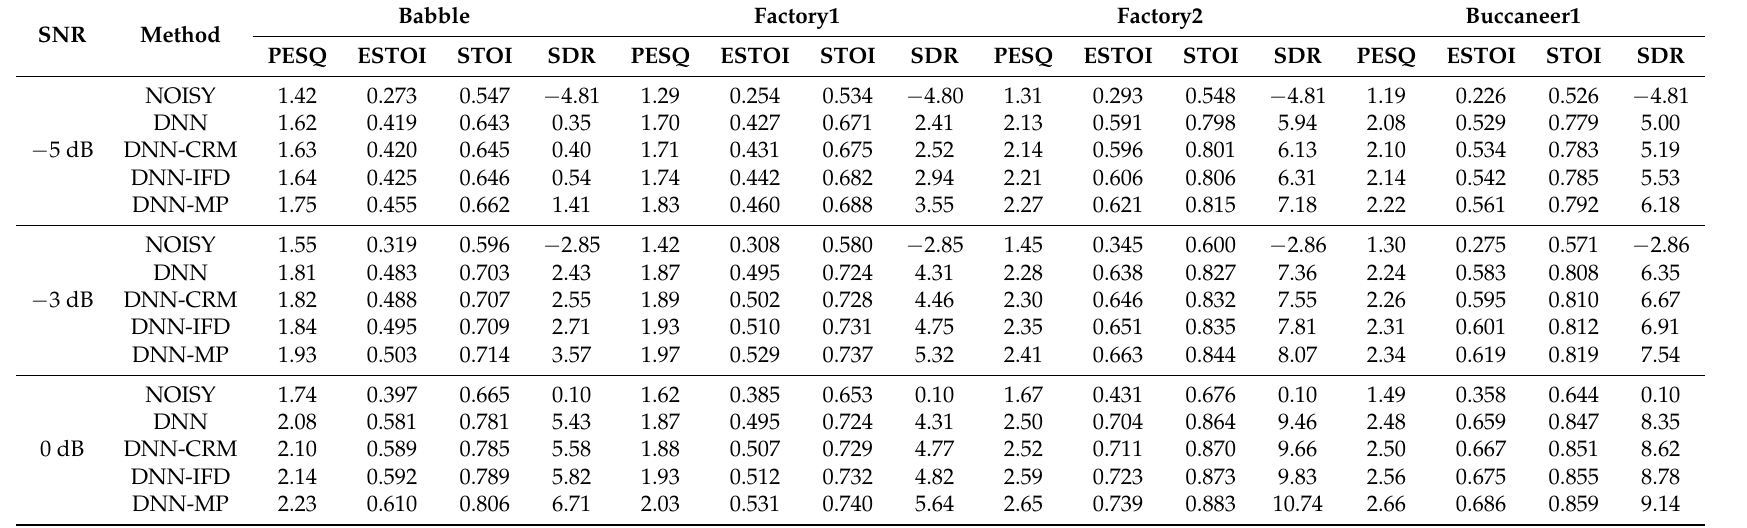
Table 1. Experiment 1: Speech enhancement performance